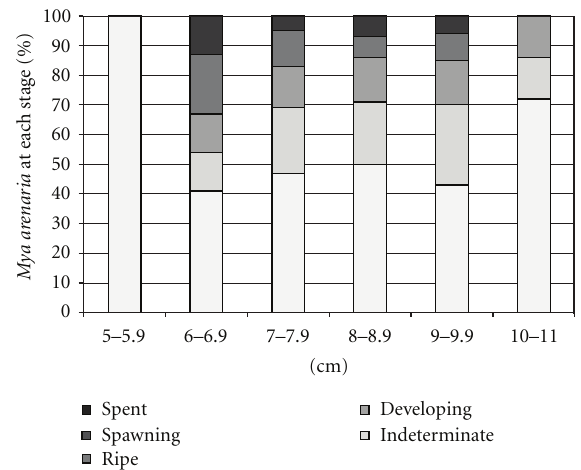
Figure 8: Relationship between male Mya arenaria length and stage of gametogenesis.